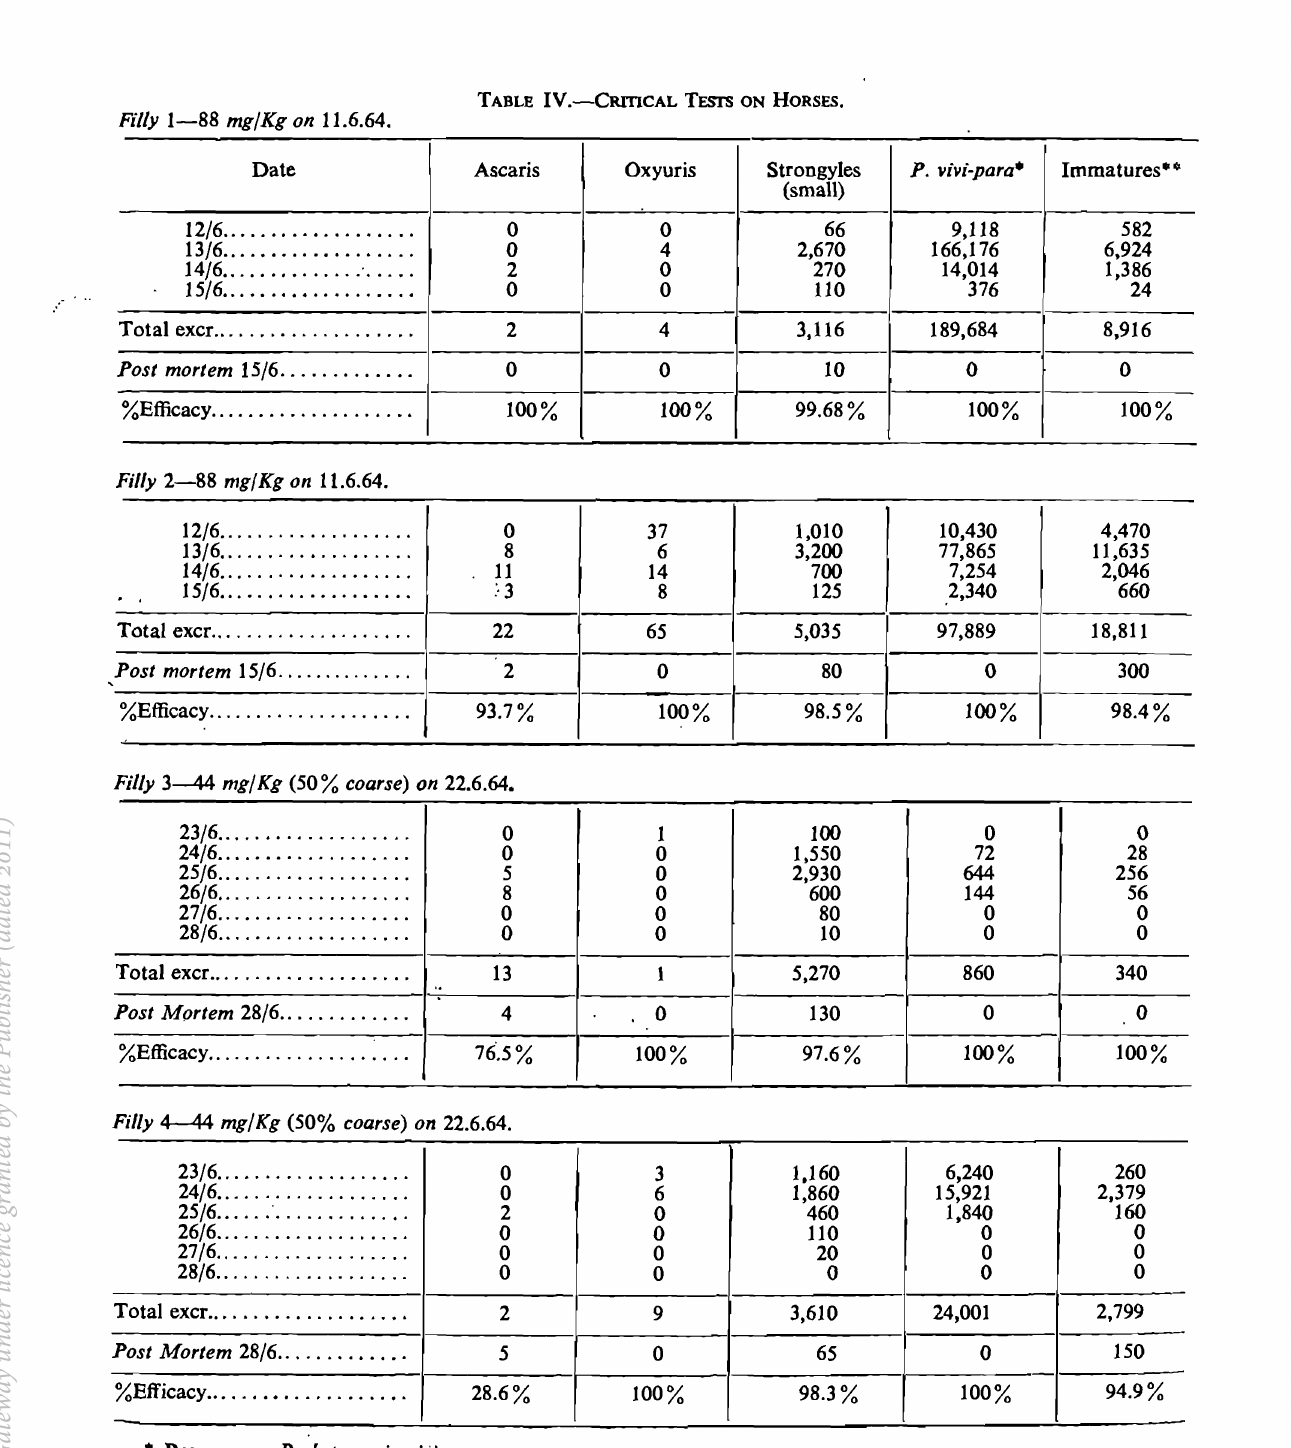
TABLE IV.-CRrncAL TESTS ON HORSES.